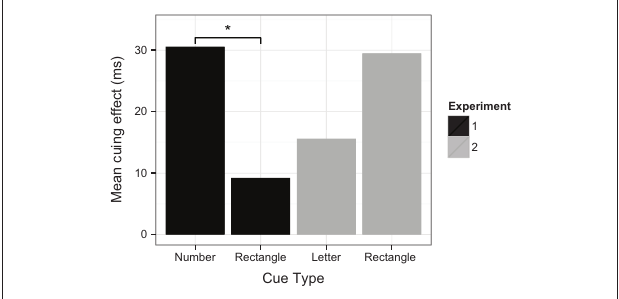
FIGURE 13 | Cuing effects for the different types of cues used in the target detection trials in Experiment 1 and 2. Asterisk denotes significance at p = 0.05. Note that the cuing effects for letter and rectangle cues in Experiment 2 were not significantly